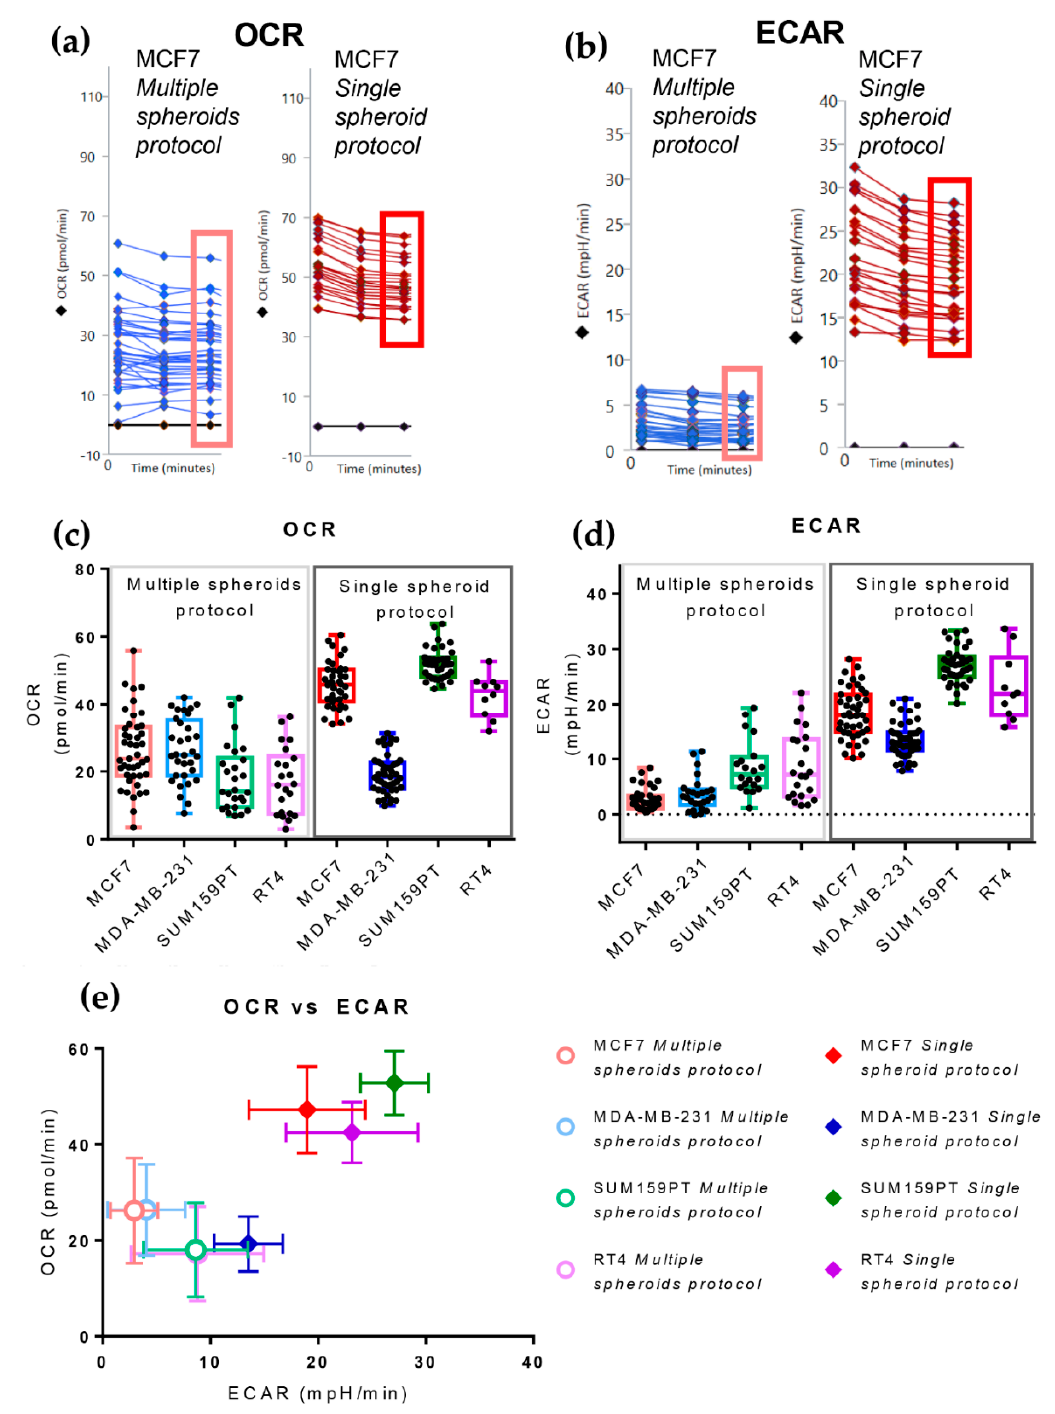
Figure 2. Comparisons of basal Oxygen Consumption Rate (OCR) and ExtraCellular Acidification Rate (ECAR) values between spheroids obtained by the Multiple and Single Spheroid Protocols . ( a , b ) The first three measurements of OCR ( a ) and ECAR ( b ), performed using an XF96 Seahorse Analyzer, showing the baseline profile of MCF7 spheroids obtained with the Multiple Spheroids Protocol (left) and Single Spheroid Protocol (right). Single measurements for every spheroid are reported to show distribution; the black line is for the background and corresponds to a zero value. The rectangles indicate the 3rd basal OCR and ECAR measurements used to generate the box and whisker plots presented in panels ( c , d ). ( c , d ) Box and whisker plots comparing basal OCR ( c ) and ECAR ( d ) of four cancer cell lines (mammary carcinoma: MCF7, MDA-MB-231, SUM159PT, and urothelial carcinoma: RT4) produced by applying the Multiple Spheroids Protocol and the Single Spheroid Protocol ; single value distribution is reported as black dots. ( e ) Correlation of OCR and ECAR values under the basal conditions of three mammary carcinoma cell lines produced with the two protocols: MCF7 (MSP n = 43; SSP n = 45), MDA-MB-231(MSP n = 32; SSP n = 45), SUM159PT